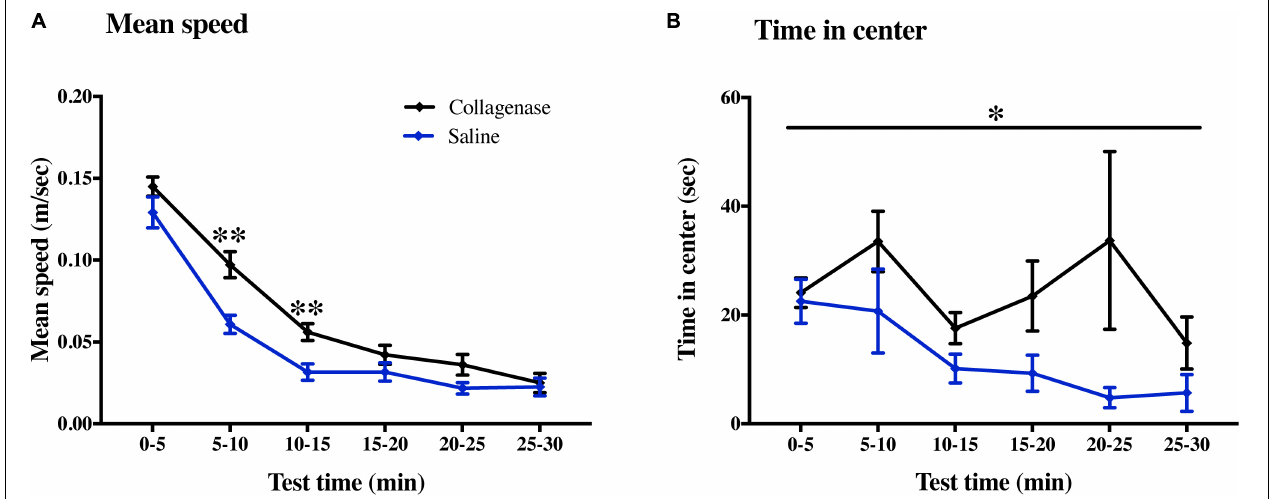
FIGURE 8 | Effect of GMH on long-term sensorimotor and cognitive functions. At P40, the open field test showed that (A) mean speed and (B) time spent in the center was affected by GMH ( n = 19) when compared to saline controls ( n = 12) . Data represented as mean ± SEM and analyzed using two-way mixed ANOVA. ∗ P < 0.05 and ∗∗ P <